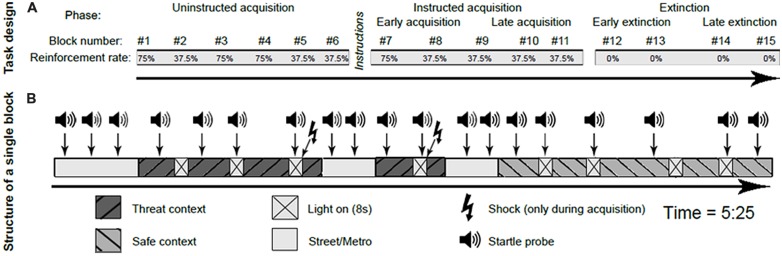
Schematic representation of the conditioning paradigm, including the task design (A) and the structure of a single block (B). This figure is adapted from Heitland et al. (2013).